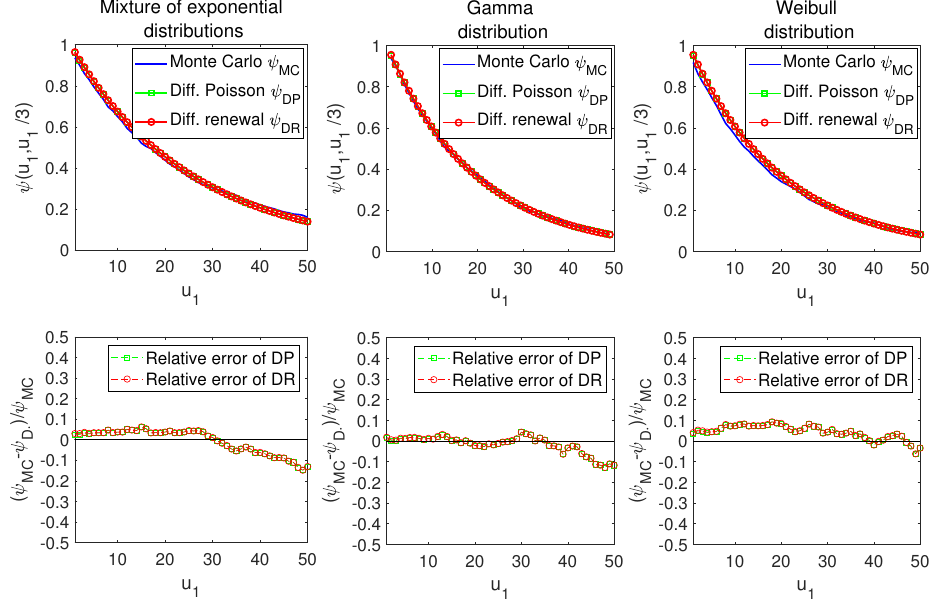
Figure 3. Ruin probabilities ( top panels) for the insurer–reinsurer model in the infinite-time horizon calculated using Monte Carlo (MC) simulations with the renewal process with α = 10, σ M = 0.1, the diffusion approximation with the Poisson process (DP) with λ = 10 and the diffusion approximation with the renewal process (DR) for selected light-tailed distributions. Respective relative errors ( bottom panels) of the approximations. In the simulations, the number of MC iterations is 10,000, parameters of claim distributions are given by Equations